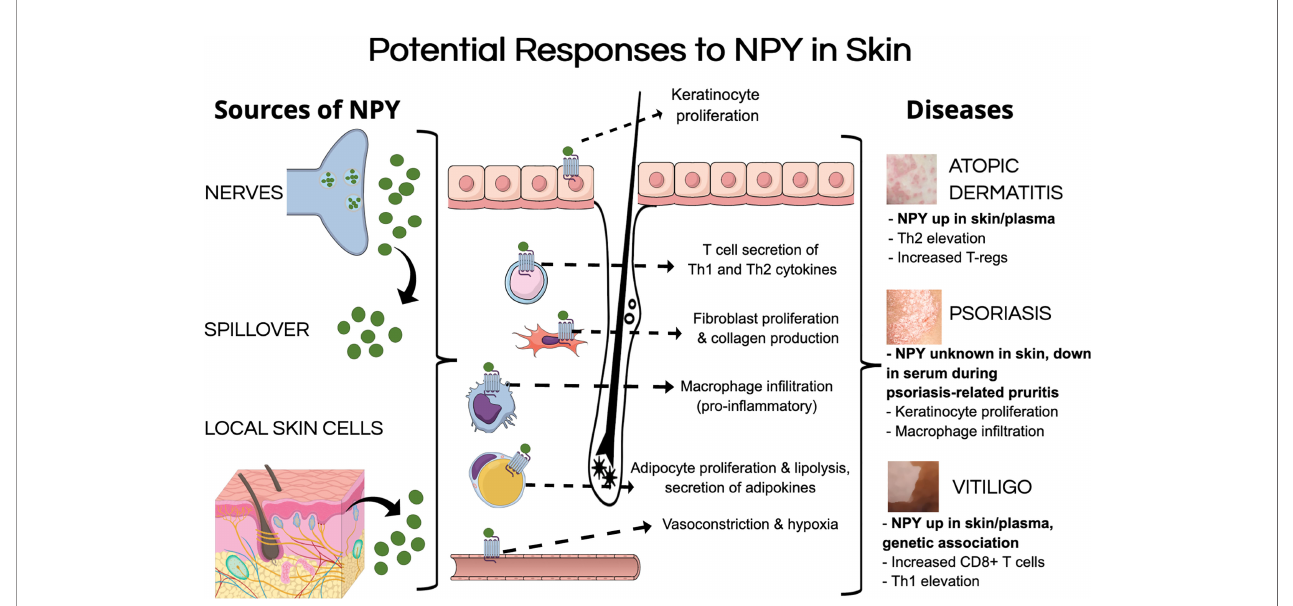
FIGURE 1 | Potential mechanisms of pathological NPY signaling in the skin. NPY levels could be elevated in the skin by multiple sources, including its secretion from nerves within the skin, spillover from circulation, and secretion from different cell types in the skin. NPY could induce pathological responses in various cell types that have been shown to express NPY receptors, including keratinocytes, fi broblasts, adipocytes, and various immune cells. These pathological responses to NPY could contribute to different aspects of in fl ammatory skin